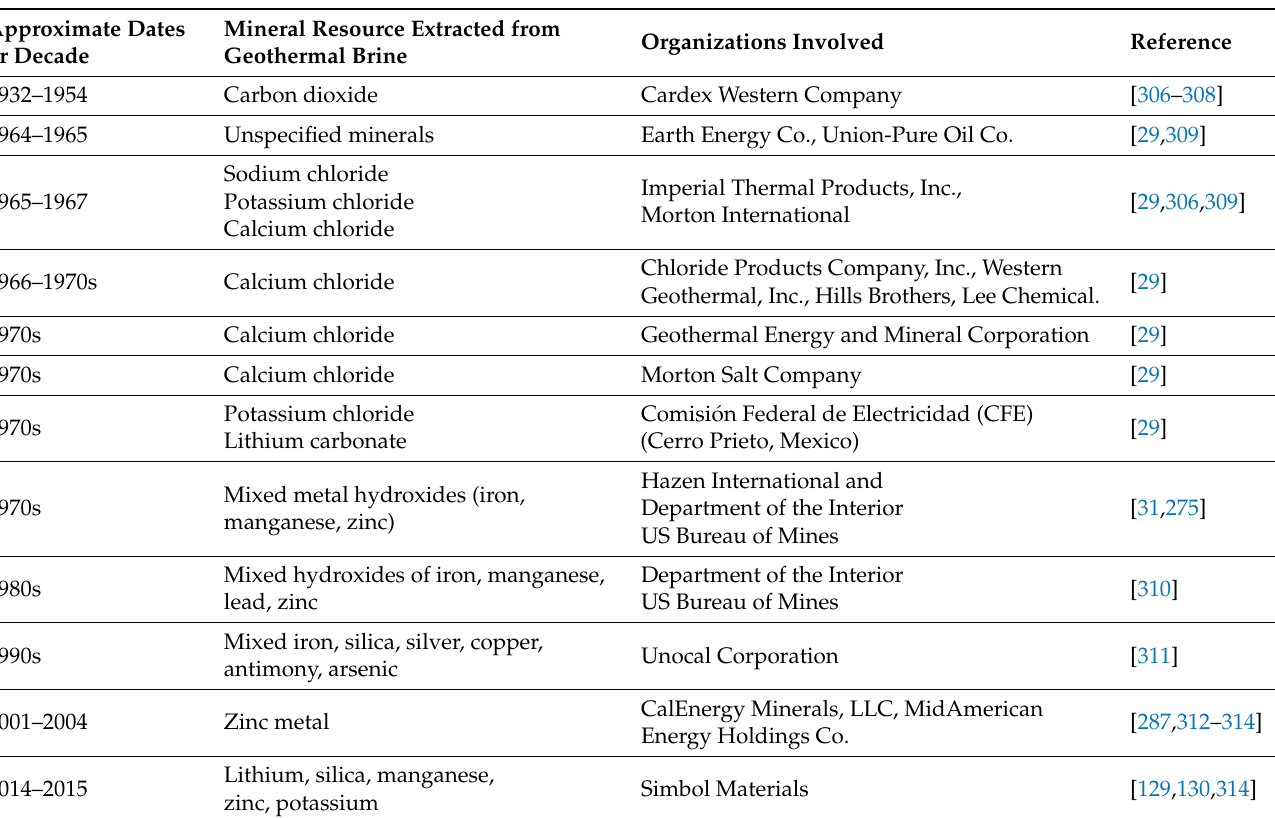
Table 13. Timeline of pilot-scale or larger geothermal mineral extraction projects in the Salton Trough geothermal resource area in California and